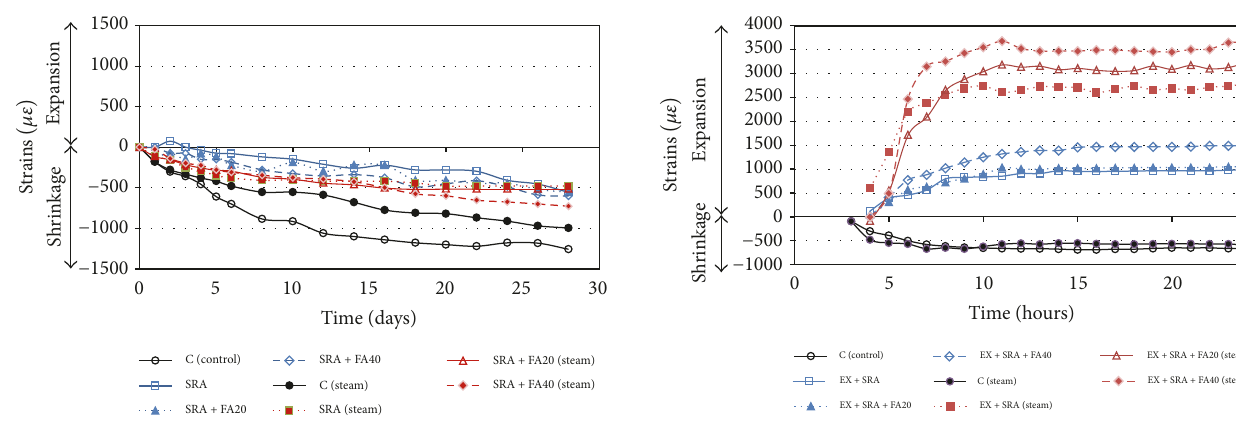
Figure 11: Total shrinkage results for SRA and SRA + FA (1 day after mixing).